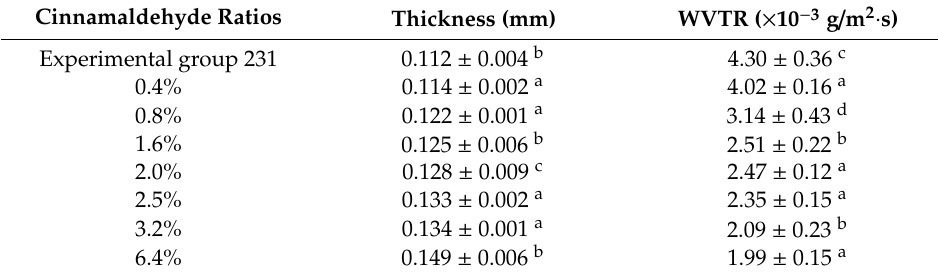
Table 5. WVTR of di ff erent CS / corn starch / cinnamaldehyde Table 5. WVTR of different CS/corn starch/cinnamaldehyde films.